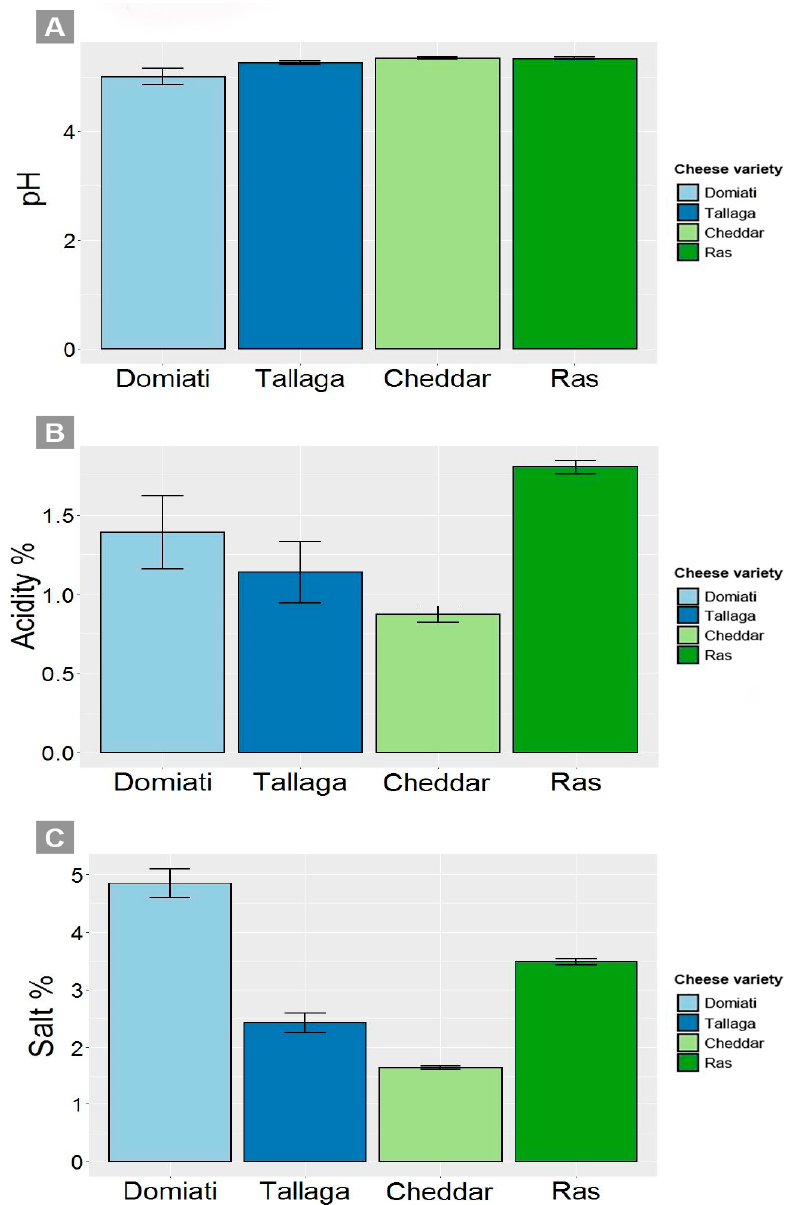
Figure 3. Bar plot of chemical composition (pH ( A ), Acidity (%)( B ), and Salt (%)( C )) of the investigated cheese samples. Data expressed as mean ± SE ( n = 15).